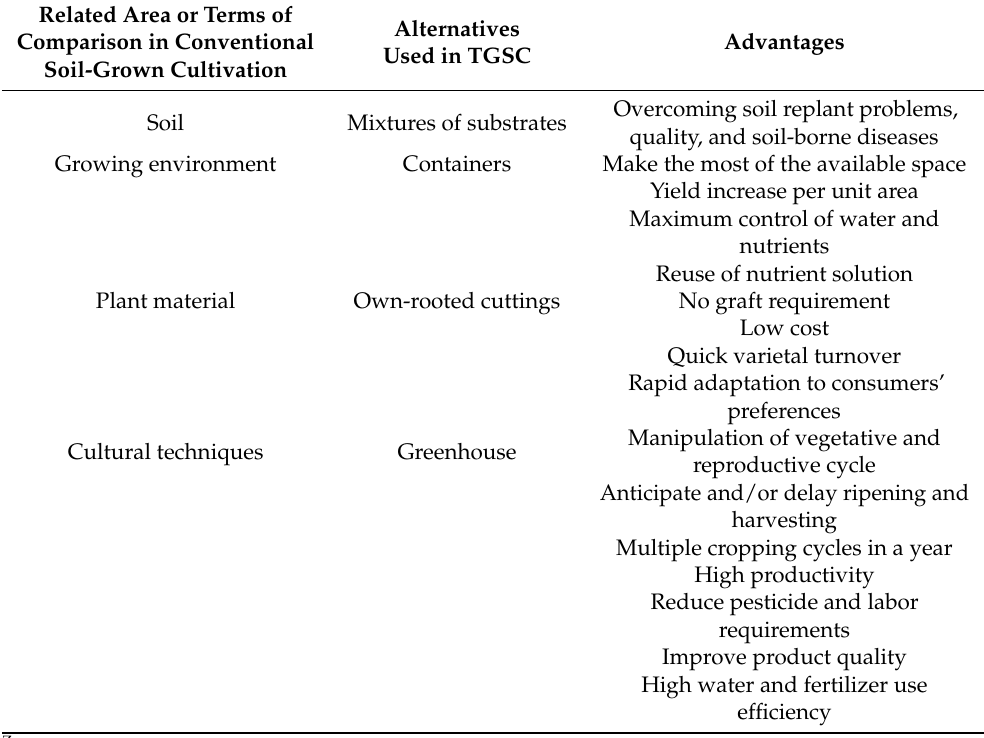
Table 1. The main advantages of soil-less table-grape cultivation (TGSC) in comparison to traditional growing systems Z